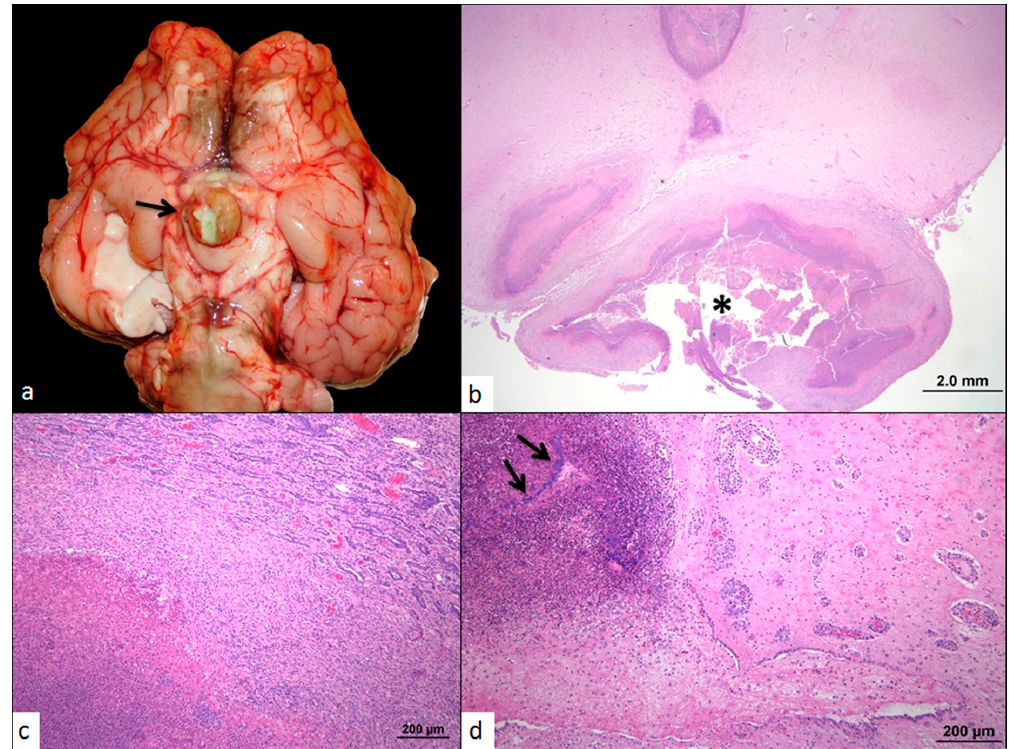
Figure 1. ( a ) Fresh brain, ventral surface: The pituitary contains a large amount of semi-solid, light yellow opaque material (arrow). Similar material extends along the meninges of the brainstem; ( b ), ( c ), and ( d ) Hematoxylin and Eosin. ( b ) More than 90% of the pituitary gland is effaced and/or replaced by a large focus of inflammation (asterisk); ( c ) Compression of the pars distalis of the pituitary (upper right corner), by the pituitary abscess; ( d ) Inflammatory cells, necrotic debris, and colonies of coccobacilli (arrows) fill the ventricles and obscure portions of the ependymal lining and adjacent neuropil. Vessels in the adjacent neutrophil are cuffed by many inflammatory cells.